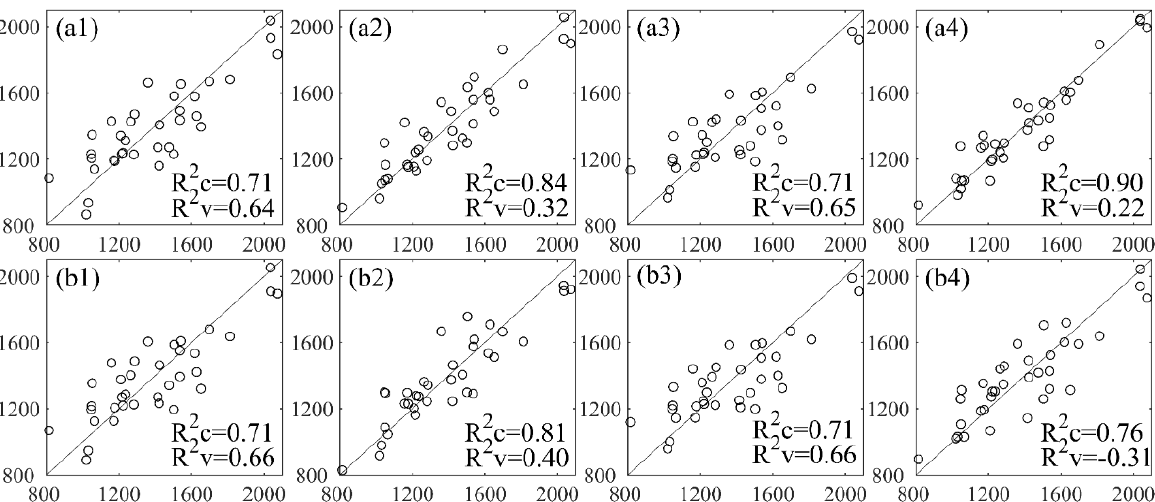
Figure 11. ( a1 – a4 ) show the calibration and validation results of the models developed with the full wavelength spectra of the spectral reflectance (R), R’, ln(1/R) and CR; Correspondingly ( b1 – b4 ) show the calibration and validation results of the models developed with the spectra of sensitive bands of the spectral reflectance (R), R’, ln(1/R) and CR. Axis X indicates the observed soil N contents of the De dataset (unit: μ g/g). Axis Y indicates the estimated soil N contents derived from each PSL model (unit: μ g/g). Table 2. The estimation accuracy of PLS models.